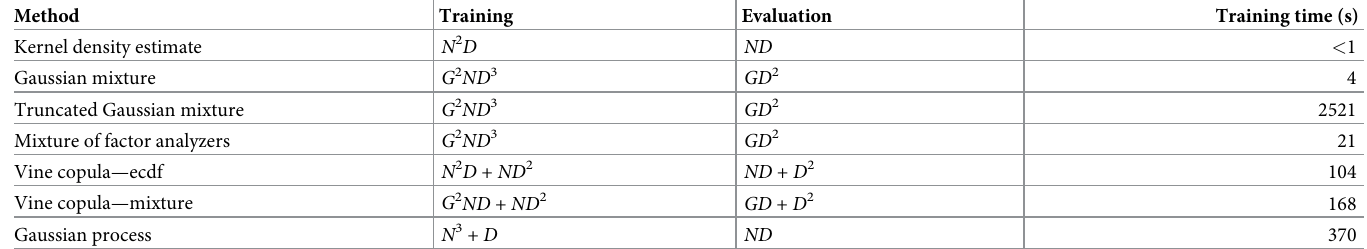
Table 2. Time complexity of training and evaluation of the approximation methods. Evaluation is the cost of evaluating one new sample. N = number of Monte Carlo samples used for the estimation, D = dimensionality, G = number of mixture components. The training time gives the number of seconds required to fit a 10-dimensional approximation on 1,000 samples using mvdens . For mixture fitting, the time for fitting a 5-component model is reported; optimizing the number of components will grow linearly with the number of components